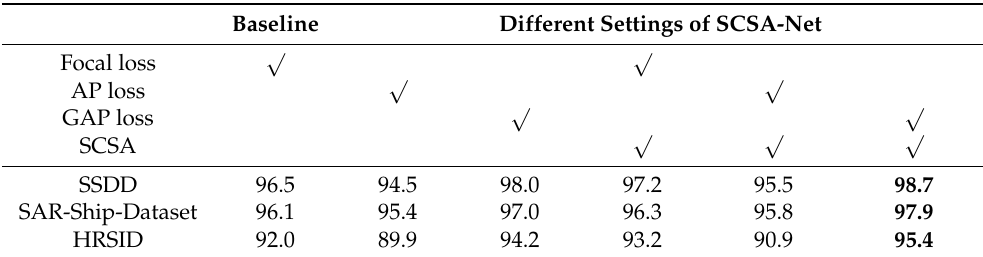
Table 1. Ablation study of SCSA-Net on SSDD, SAR-Ship-Dataset, and HRSID. Baseline Different Settings of SCSA-Net √ √ Focal loss AP Baseline